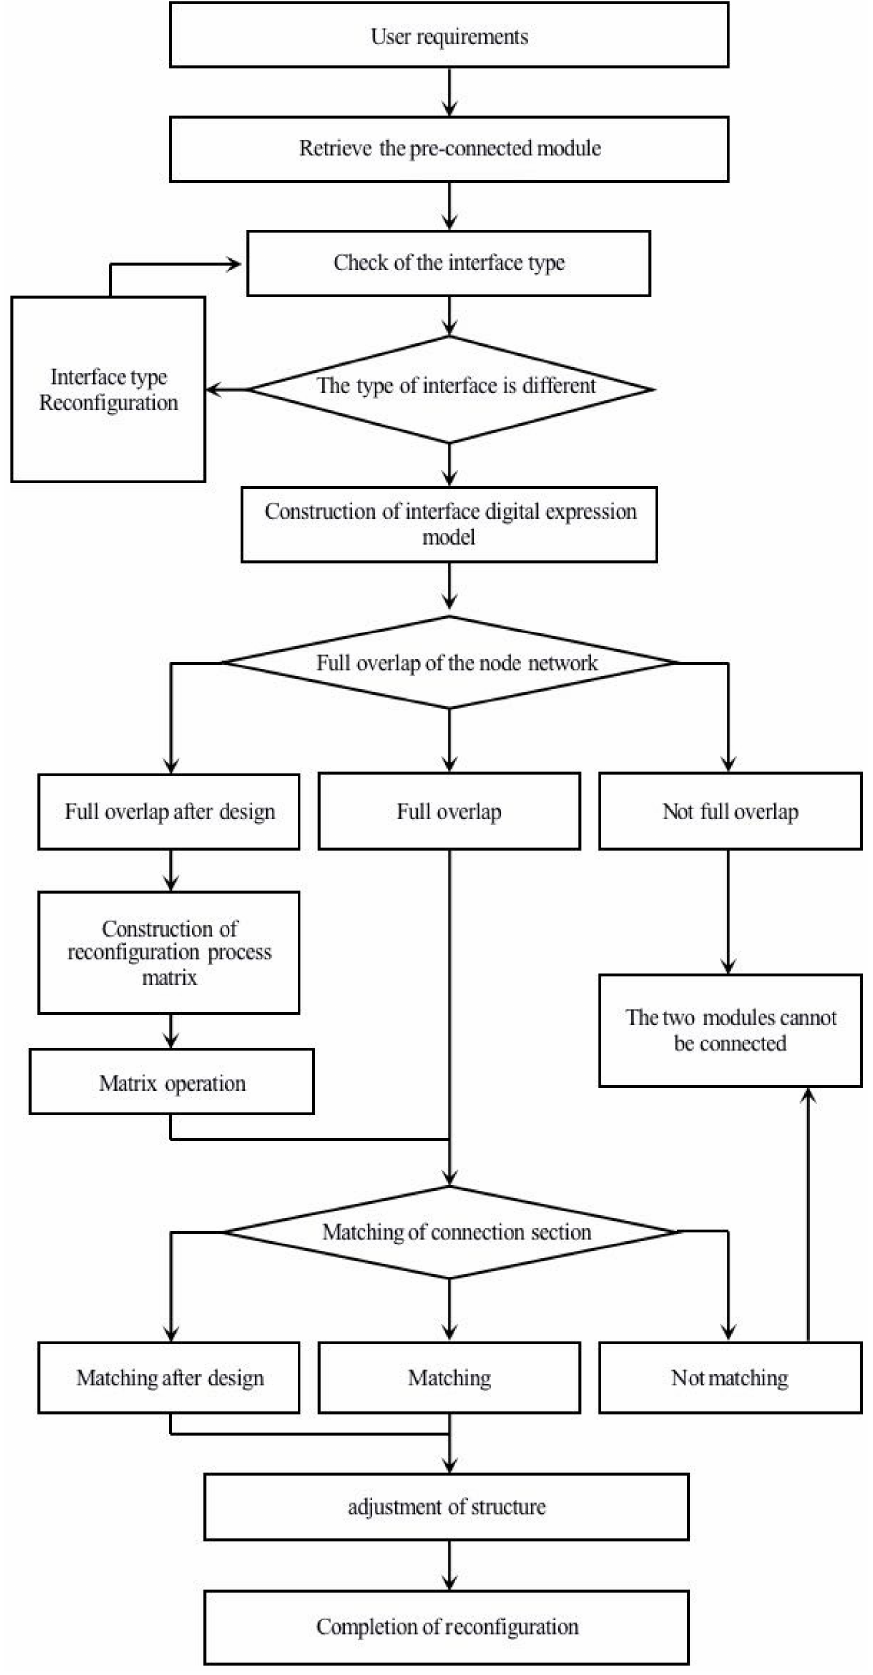
Figure 7. Process of module reconfiguration based on the interface digital expression